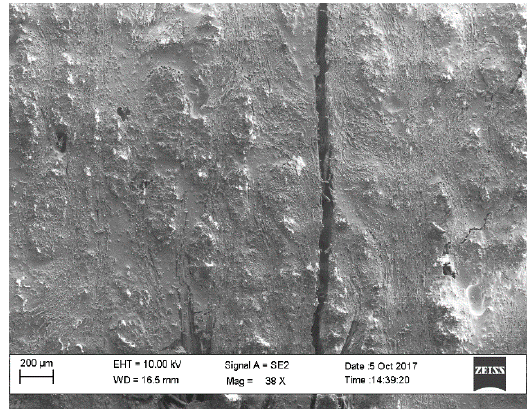
Figure 9. Visualization of delamination.